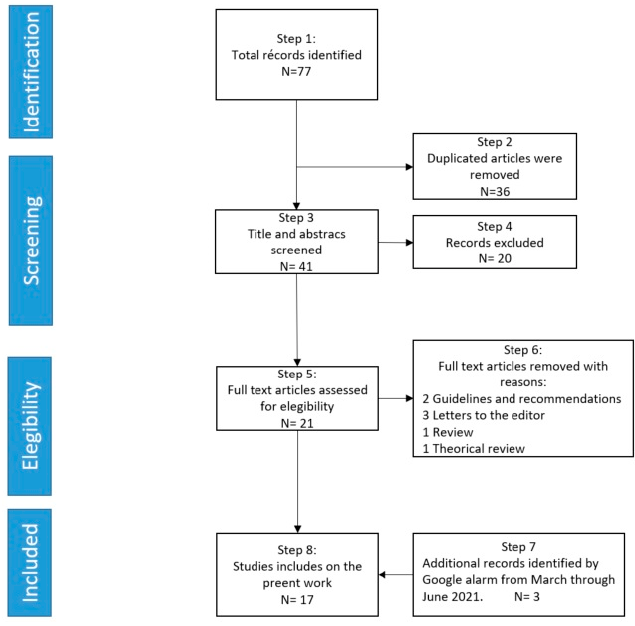
Figure 1. PRISMA review flow.